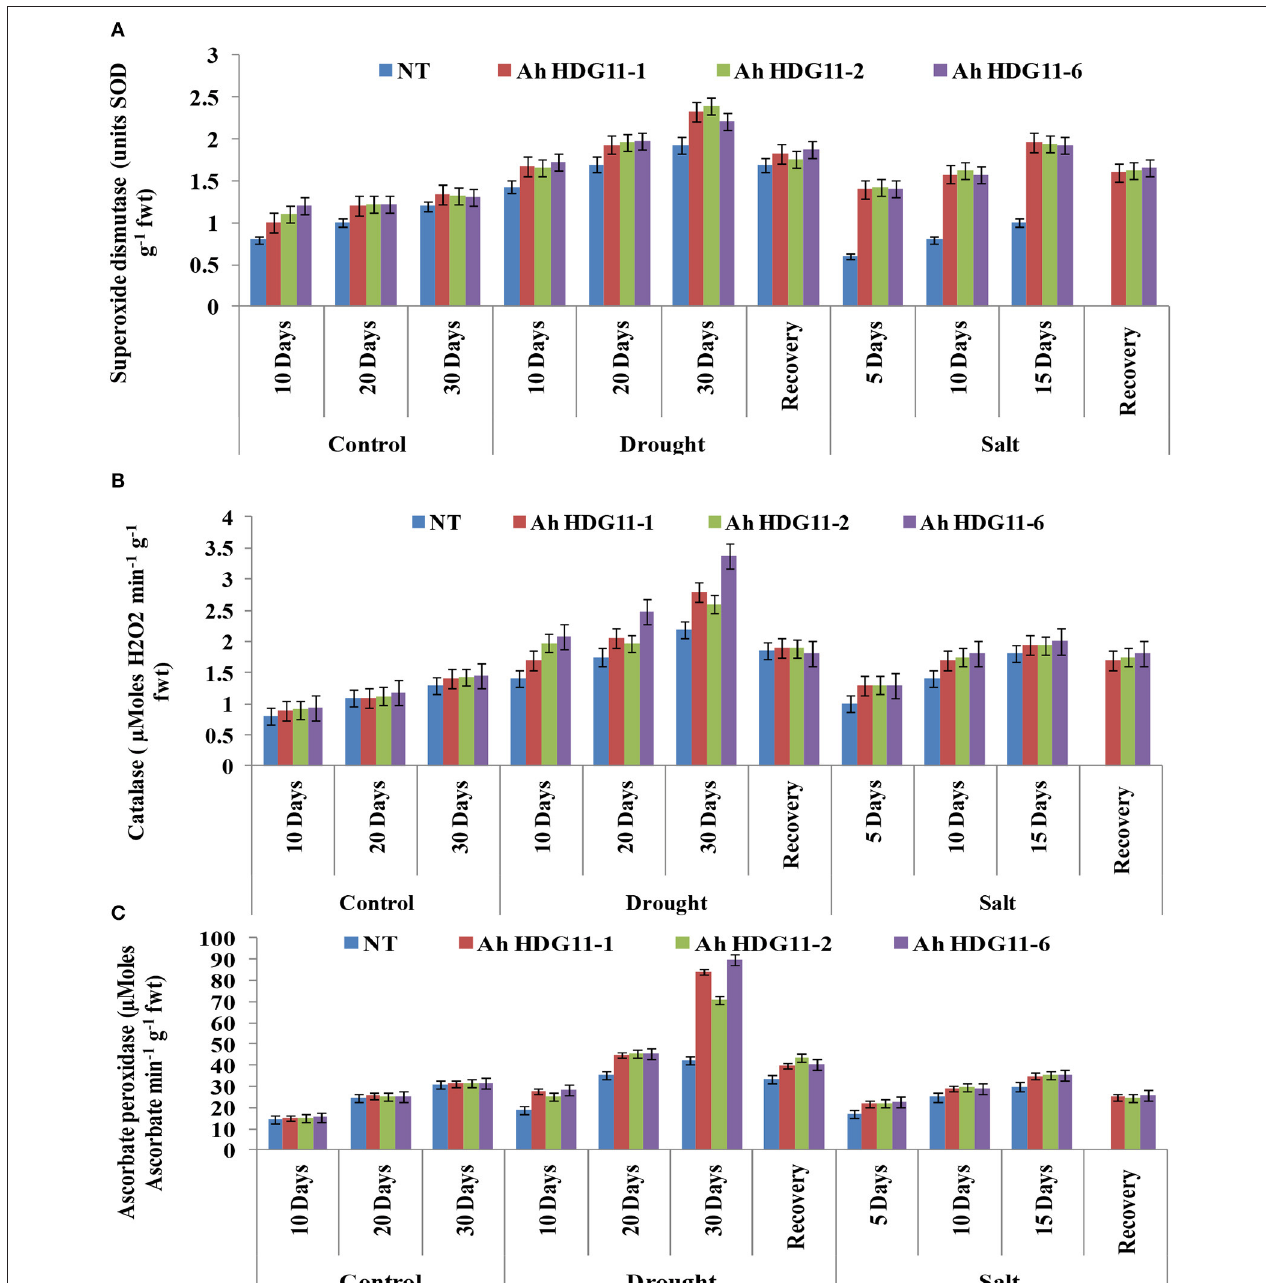
FIGURE 8 | Physiological and biochemical analysis of transgenic lines AhHDG11-1, AhHDG11-2, AhHDG11-6 along with the Non-transgenic (NT) plants. ( A) Superoxide Dismutase (SOD) (B) Catalase (CAT) (C) Ascorbate Peroxidase (APX).